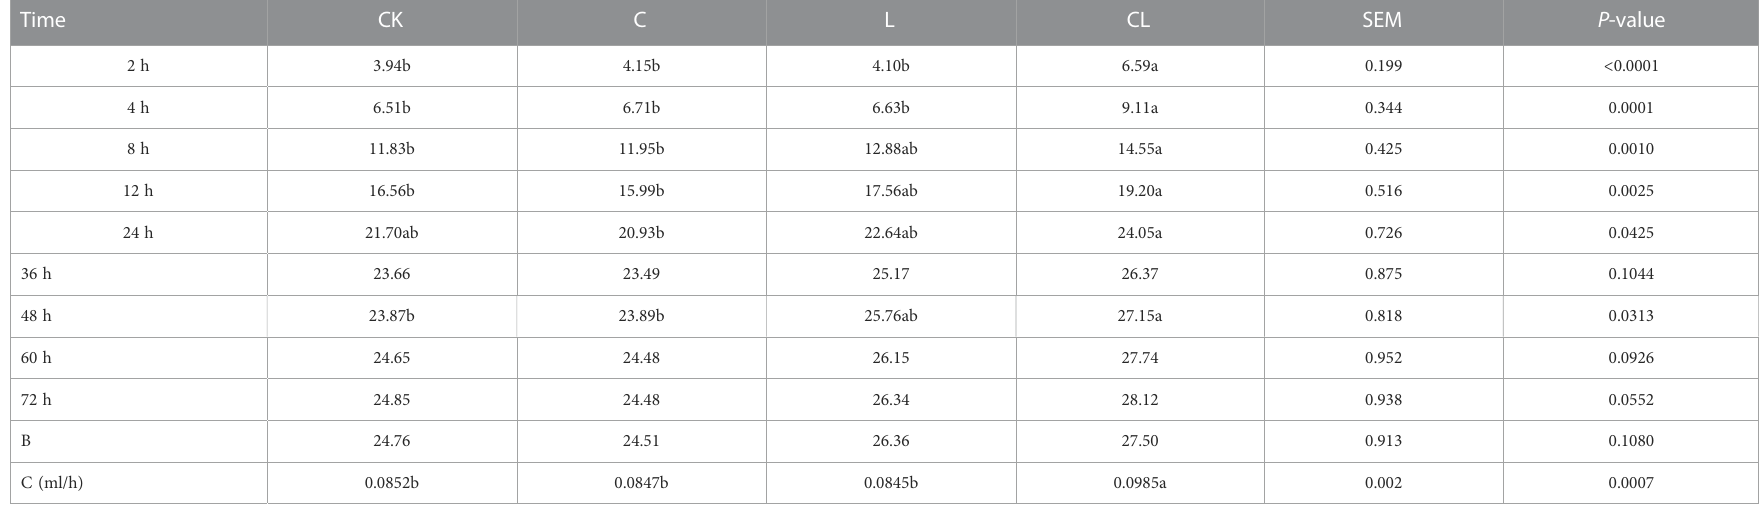
Different letters in the same row indicate signi fi cant differences ( p < 0.05), and the same or no letters indicate non-signi fi cant differences ( p > 0.05). CK, no additive; C, Cellulase; L, Lactiplantibacillus plantarum ( L. plantarum ); CL, Cellulase + L. plantarum ; B, theoretical maximum gas production; C, production period rate; SEM, Standard error of the